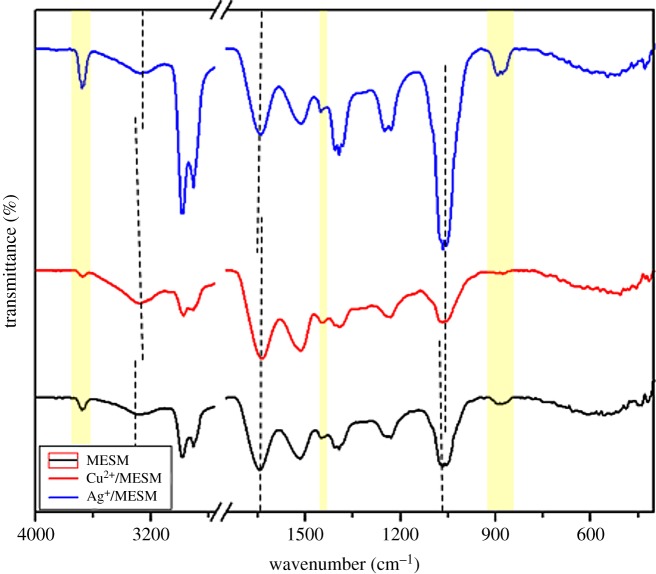
FTIR spectra of MESM, Cu2+/MESM and Ag+/MESM composites.